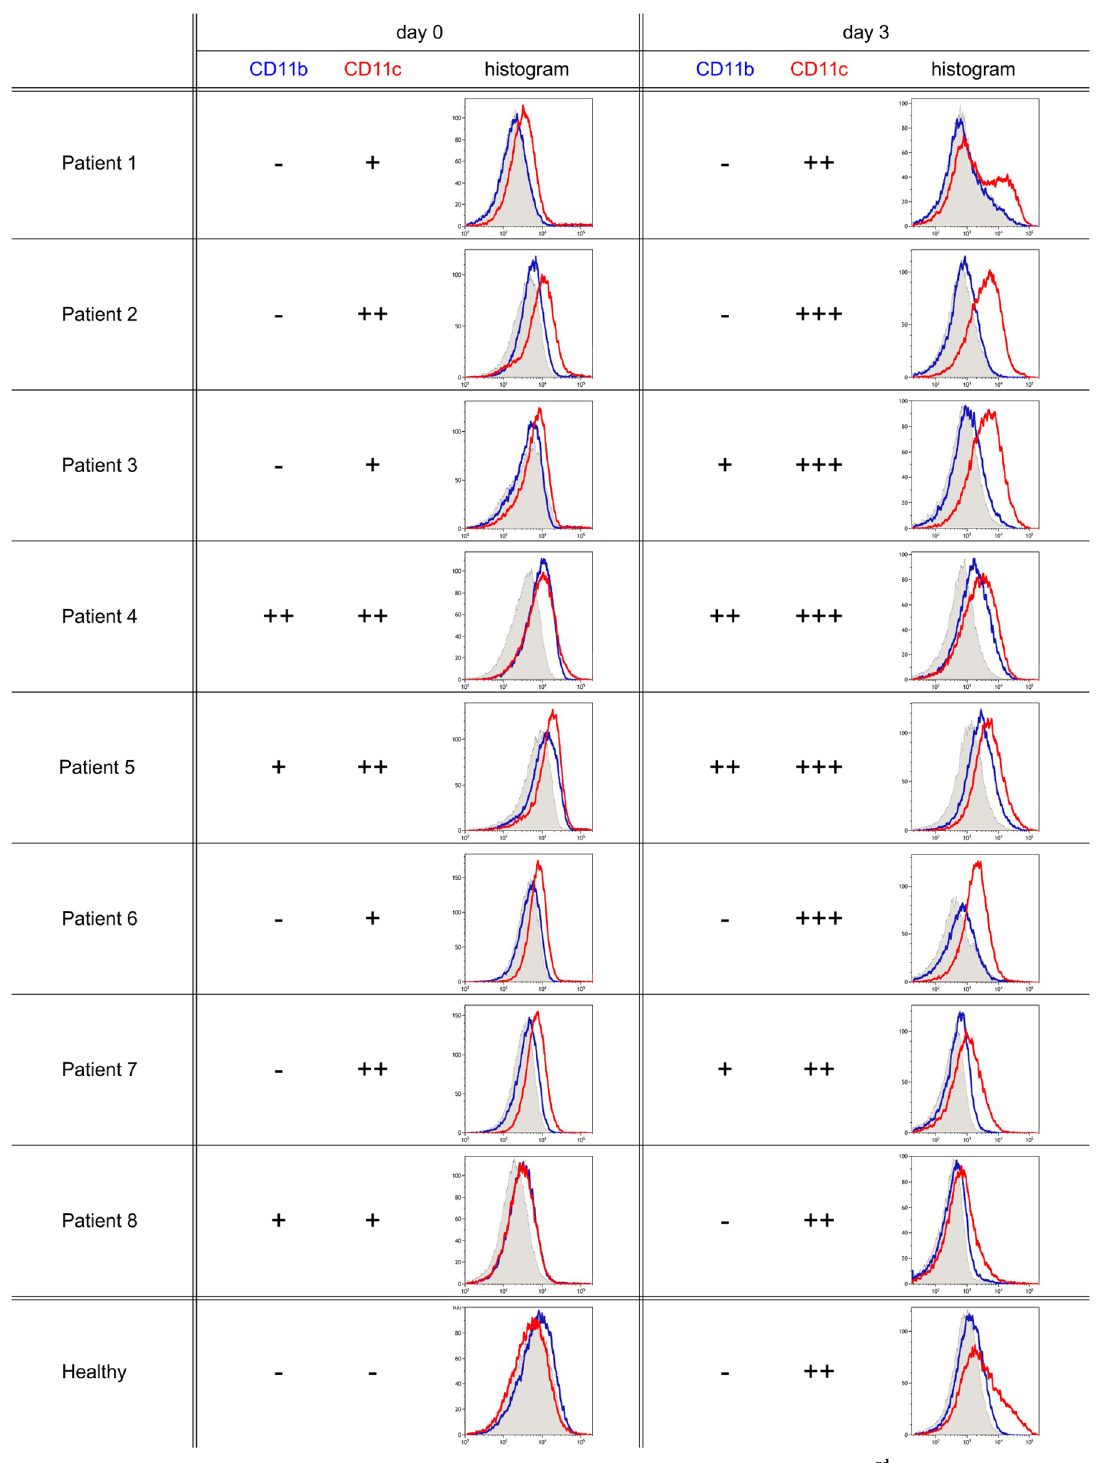
Fig 2. The expression of CD11b and CD11c on B cells of CLL patients directly after isolation and on the 3 rd day of culture. CR3 (blue) and CR4 (red) expression was measured by flow cytometry on B cells of eight CLL patients directly after isolation and on the 3 rd day of cell culture. As controls, B cells of healthy donors were investigated (in that case one representative histogram is shown of four independent experiments with similar results). On the histograms, the abscissa refers to the measured fluorescence intensity, while the ordinate refers to cell count. Expression was ranked positive if relative mean fluorescence intensity (RMFI) was higher than 150%.